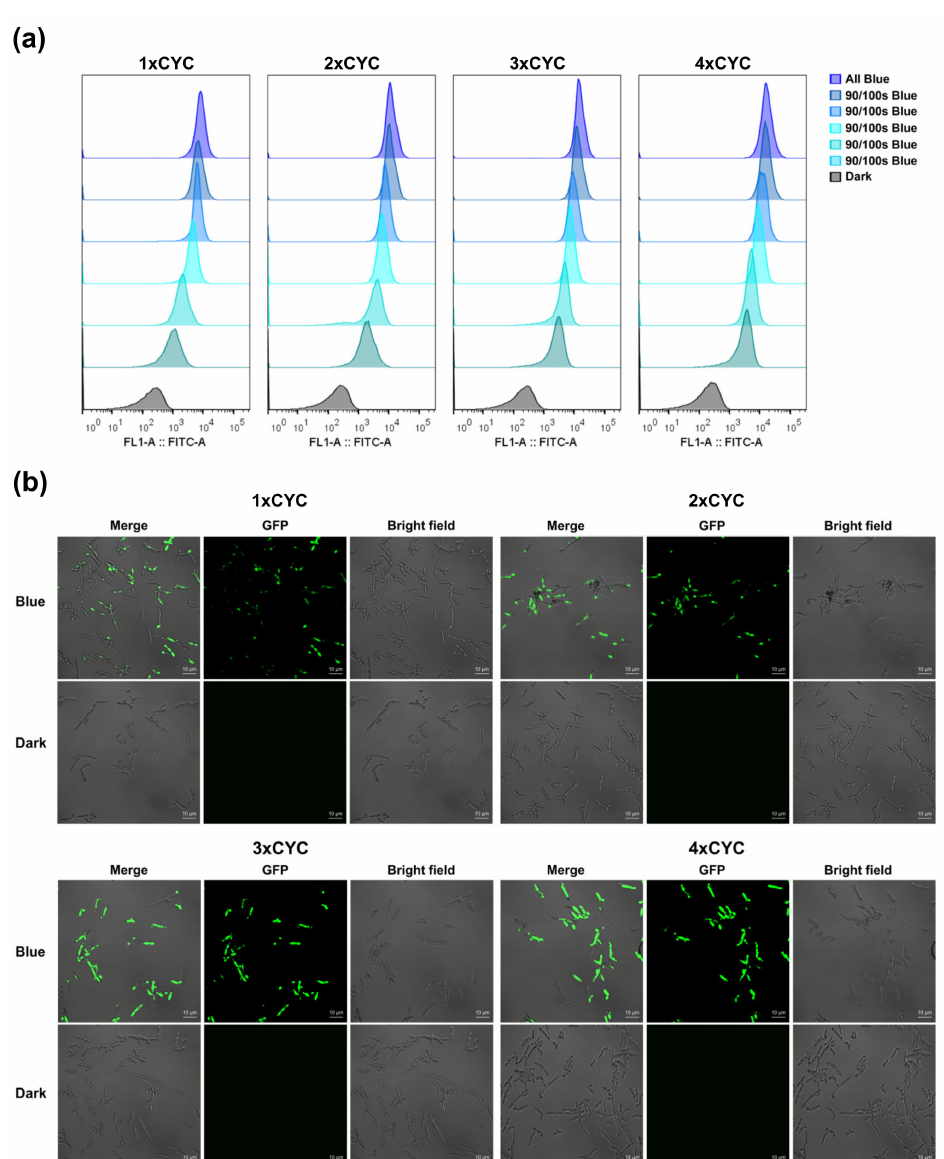
Figure 4. Assessment of the performance at the single-cell level. ( a ) Flow cytometry of Po1g cells harboring 1~4 × CYC pYLBI circuits. All of the cells were induced to the maximum. Flow cytometry images of every group are sorted as All Blue, 90/100 s Blue, 70/100 s Blue, 50/100 s Blue, 30/100 s Blue, 10/100 s Blue, and Dark from top to bottom. A total of 5 × 10 4 cells were analyzed for each population. The results acquired by analyzing the data from flow cytometry are consistent with the data obtained by the microplate reader. ( b ) The confocal images of All blue and Dark groups. From left to right are the Merge group, GFP group, and Bright field group, respectively. The gain of every image remains consistent. The single cells of all blue groups showed strong GFP signals. There was no GFP signal in the dark groups. Scale bars represent 10 µ m. All above-mentioned experiments verify thepYLBI systems have a strong response to blue